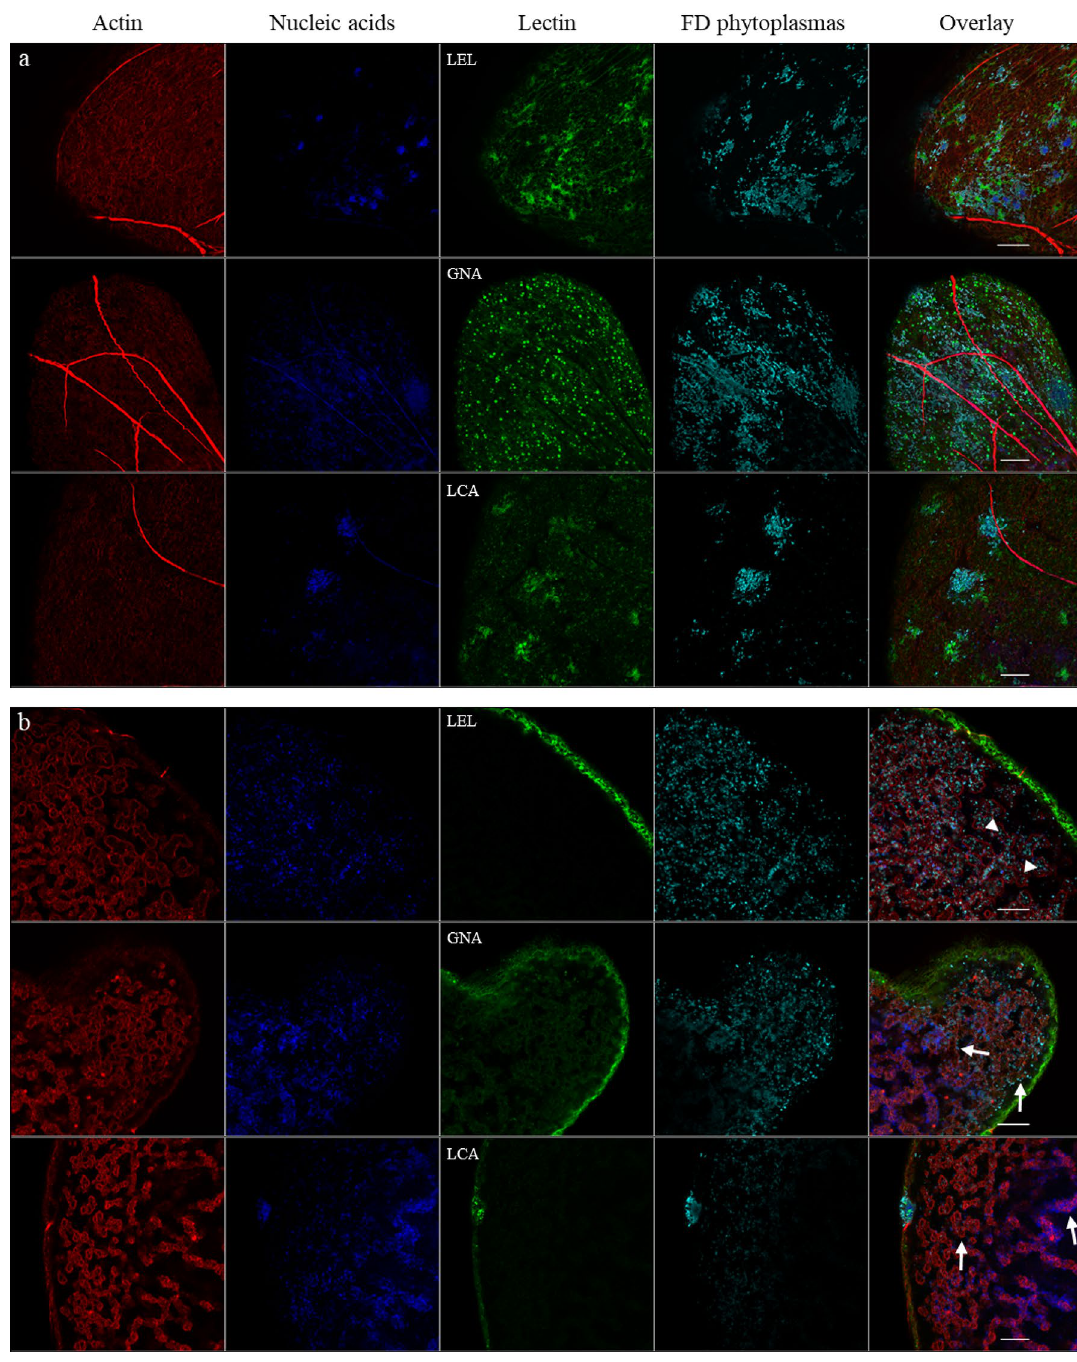
Figure 4. Magnification of salivary glands of FDP-infected E . variegatus stained with fluorescent LEL, GNA and LCA lectins by laser scanning microscopy with an Airyscan detector. FDPs were stained with anti-VmpA antibodies and Alexa 633-secondary antibodies and (cyan), cell nuclei with DAPI (blue), actin filaments with Alexa 568-phalloidin (red) and glycoconjugates with FITC-lectins LEL, GNA and LCA (green). ( a ) View of the infected salivary gland cell surface. ( b ) View of the inside of infected salivary gland cells. Arrows indicate structures resembling apical membranes described by Koinuma et al. 16 around which phytoplasmas are grouped. Arrowheads indicate phytoplasmas that crossed the apical plasma membrane. Scale bar 10